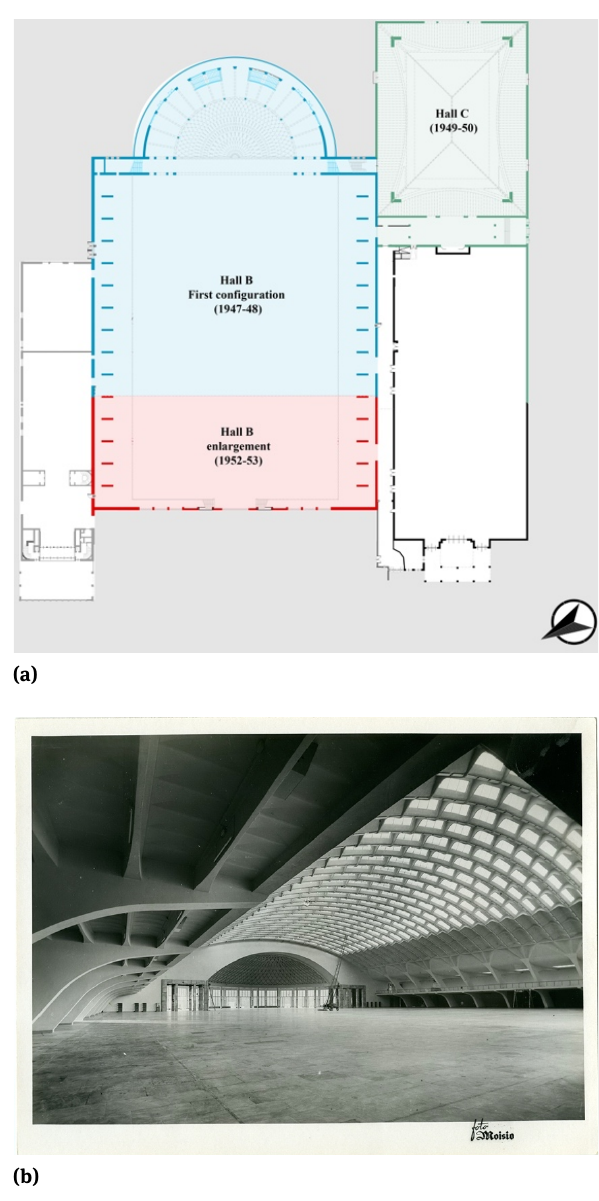
Figure 1: (a) Torino Esposizioni plan: the large hall with the semi- circular apse is Hall B built in 1948 (in blue) and enlarged in 1953 (in red), and the smaller Hall C built in 1950 (in green). (b) An interior of Hall B after completion in 1948 (photo by Aldo